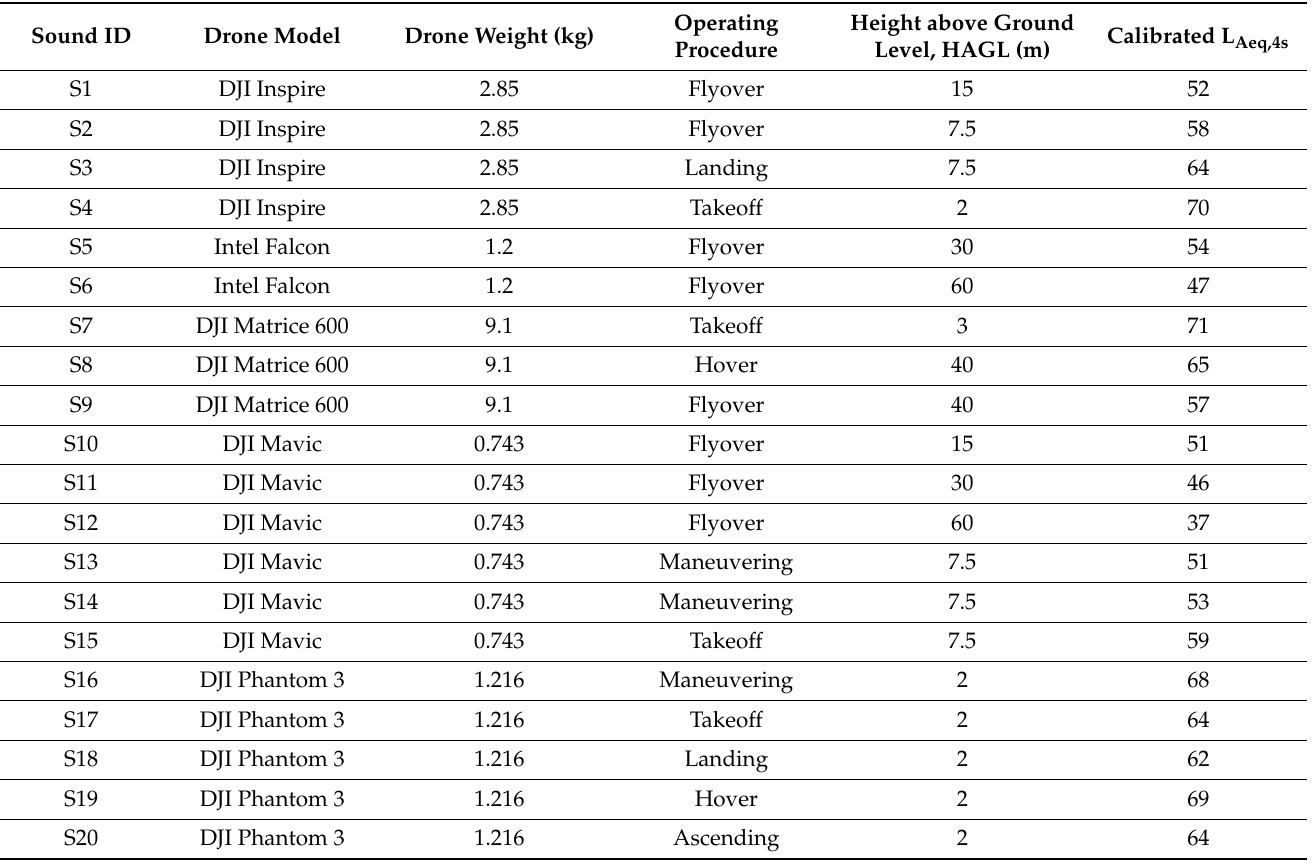
Table 1. Drone sounds used in the subjective